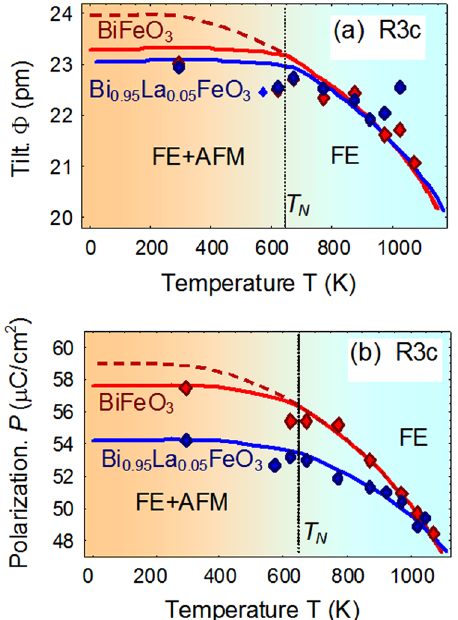
Fig. 3 Temperature dependence of a AFD order parameter Φ (oxygen displacement from symmetric position) and b recalculated spontaneous polarization P in R3c phase. Empty and fi lled diamonds correspond to experimental results for pure BiFeO 3 and doped with 5% of La, respectively measured in this work. Solid curves represent the fi tting with parameters from the Table 2. Dashed curves for BiFeO3 are calculated without biquadratic AFD – AFM and FE – AFM couplings